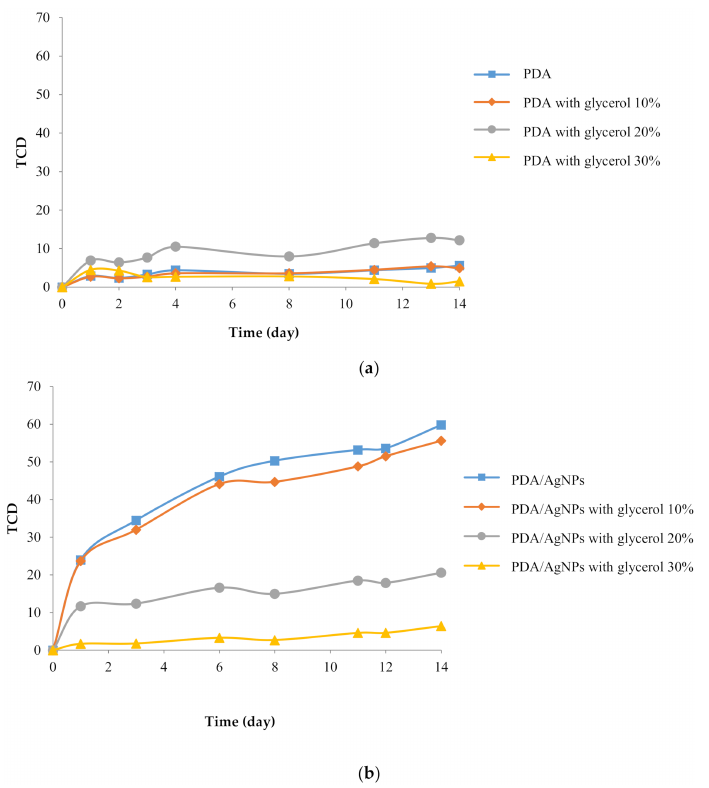
Figure 3. Changes in the total color di ff erence (TCD) of ( a ) polydiacetylene (PDA) with di ff erent amounts of glycerol and ( b ) PDA / silver nanoparticles (AgNPs) with di ff erent amounts of glycerol. The compounds were embedded in CMC films at a 1:3 PDA:AgNP ratio (prepared with 30 mg / L AgNPs) and at 35 ◦